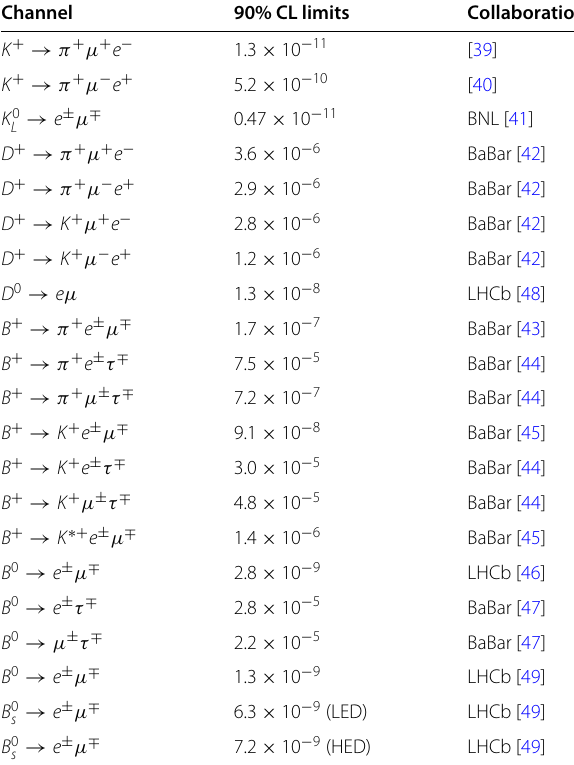
Table 3 The current upper limits of flavor violating semileptonic or leptonic decays related to K , D and B . The abbreviations are as follows: LED means light eigenstate dominate and HED is